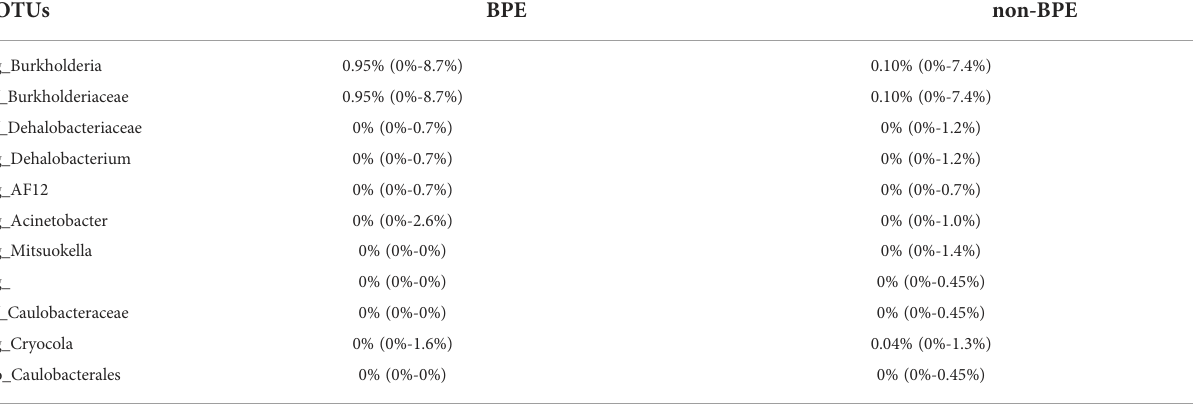
TABLE 3 The abundance of OTUs with signi fi cant differences between the prostate microbiota of the BPE and non-BPE